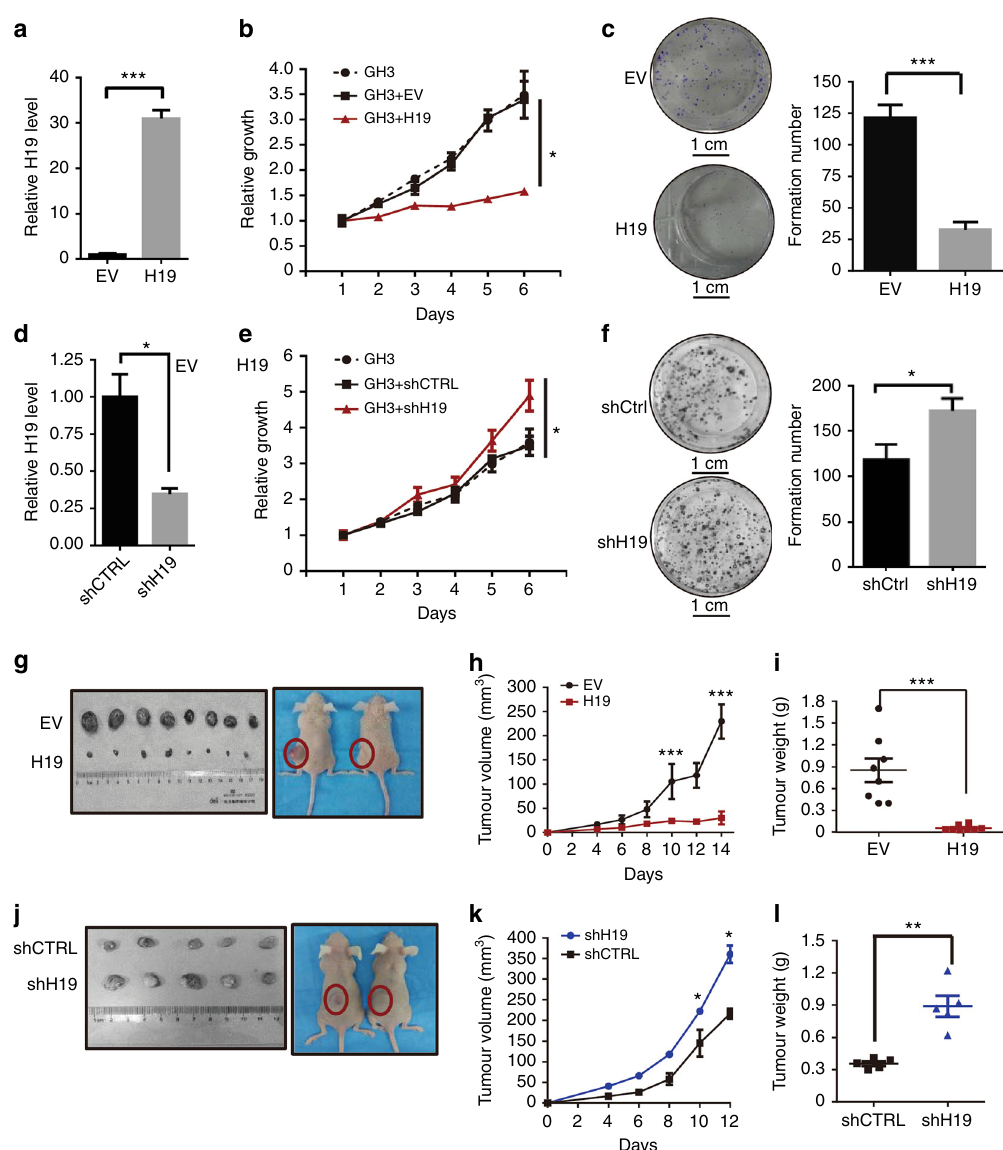
Fig. 2 H19 inhibits the growth of pituitary tumours both in vitro and in vivo. a H19 is stably expressed in GH3 cells with a lentiviral H19 overexpression construct but not in those with a control EV. The H19 level was monitored by qRT-PCR and normalized to GAPDH expression. b H19 overexpression inhibits GH3 cell proliferation in vitro. For 6 days, cell viability was periodically measured with an MTS assay ( n = 5, * p < 0.05). c H19 overexpression suppresses the colony formation rate of GH3 cells. Cells were seeded into a six-well plate with 200 cells per well and cultured for 10 days, followed by crystal violet staining and colony counting (scale bar,1 cm, *** p < 0.001). d GH3 cells were infected with lentiviral H19 shRNA or a control shRNA. H19 RNA levels were measured by qRT-PCR and normalized to GAPDH. e H19 knockdown enhances GH3 cell proliferation. For 6 days, the proliferation of GH3 cells infected with lentiviral H19 shRNA or a control shRNA was periodically analysed with an MTS assay ( n = 5, * p < 0.05). f H19 knockdown enhances the colony formation rate of GH3 cells. Cells stably expressing shH19 or a control shRNA were seeded into six-well plates with 200 cells per well and cultured for 10 days, followed by crystal violet staining and colony counting (scale bar, 1 cm, n = 5, * p < 0.05). g H19 overexpression inhibits GH3 tumour growth in vivo. First, 1 × 10 6 H19-overexpressing GH3 cells (OE group) or control GH3 cells (EV group) were subcutaneously grafted into nude mice. At the end of the experiments, mice bearing tumours were sacri fi ced, and the tumour tissues were collected, photographed ( g ) and weighed ( i , *** p < 0.001). h The growth of xenograft tumours was measured by tumour volume every other day (volume = width 2 × length × 1/2). j H19 knockdown accelerates GH3 tumour growth in vivo. In total, 1 × 10 6 H19 stable knockdown GH3 cells (shH19 group) and control GH3 cells (shCTRL group) were subcutaneously grafted into nude mice. At the end of the experiments, mice bearing tumours were sacri fi ced, and the tumour tissues were collected, photographed ( j ) and weighed ( l , ** p < 0.01). k The growth of xenograft tumours was measured by tumour volume every other day (volume = width 2 × length × 1/2). Error bars are the mean ± SEM values. Two-tailed Student ’ s t -test was used for statistical kinase B/mammalian target of rapamycin) 10 , MAPK/ERK (mito- tumourigenesis 33 . Surprisingly, H19 expression in GH3 cells had gen-activated protein kinase/extracellular regulated protein no effect on the basal or inducible activities of ERK1/2, p38, JNK, kinases) 32 and JNK (c-Jun N-terminal kinase) 32 signalling path- p65, AKT and the expression levels of RhoA, RhoB, RhoC and ways, because their abnormal activities are associated with Rictor (Supplementary Fig. 4a – c). These data indicate that H19